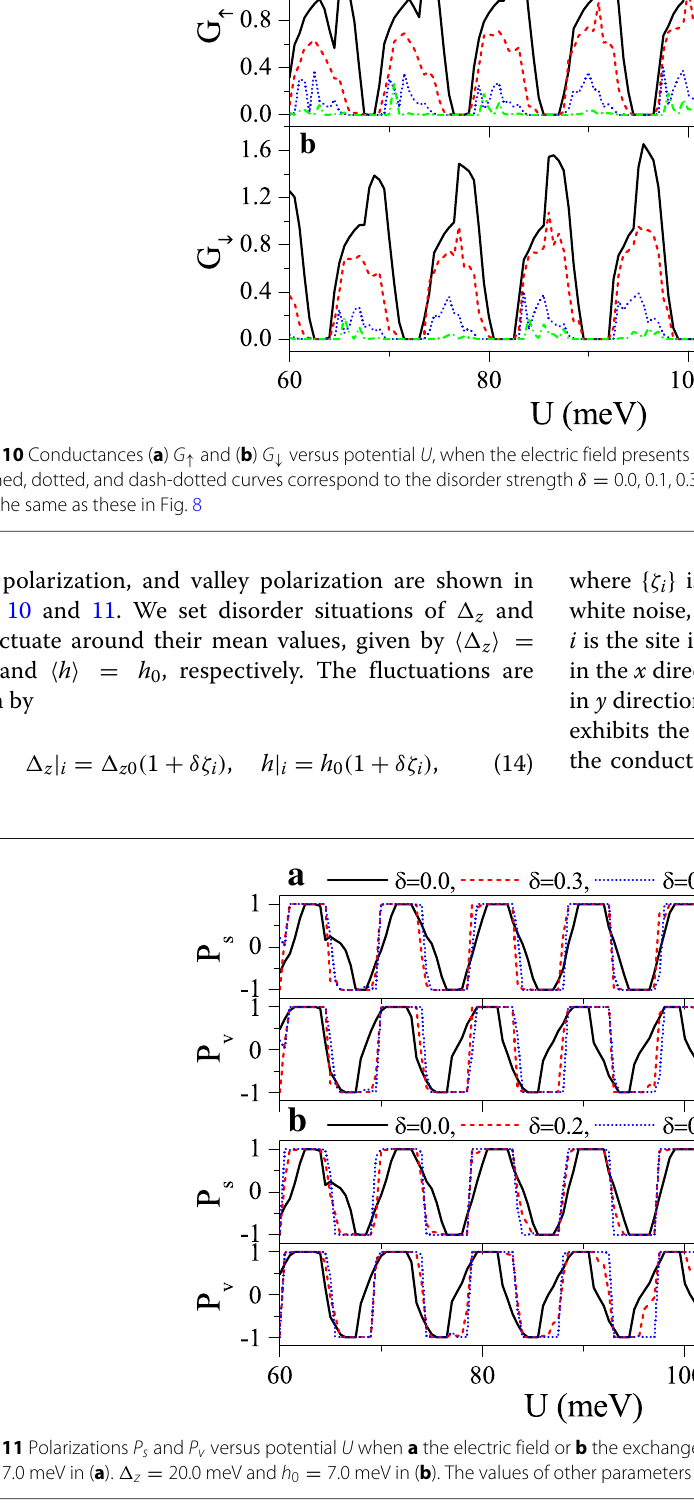
Fig. 11 Polarizations P s and P v versus potential U when a the electric field or b the exchange field presents disorder. (cid:2) z 0 = 20.0 meV and h = 7.0 meV in ( a ). (cid:2) z = 20.0 meV and h 0 = 7.0 meV in ( b ). The values of other parameters are the same as these in Fig.